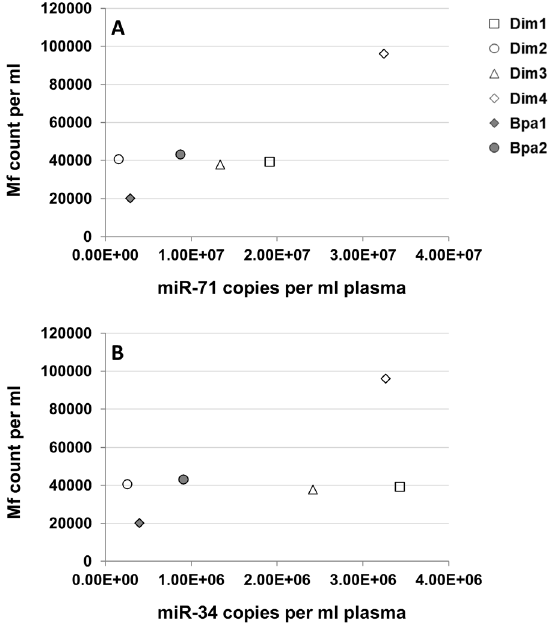
Figure 2. Relationship between miRNA copies per ml plasma and microfilaria counts. A: miR-71; B: miR-34. Empty symbols represent D. immitis- and filled symbols stand for B. pahangi -infected